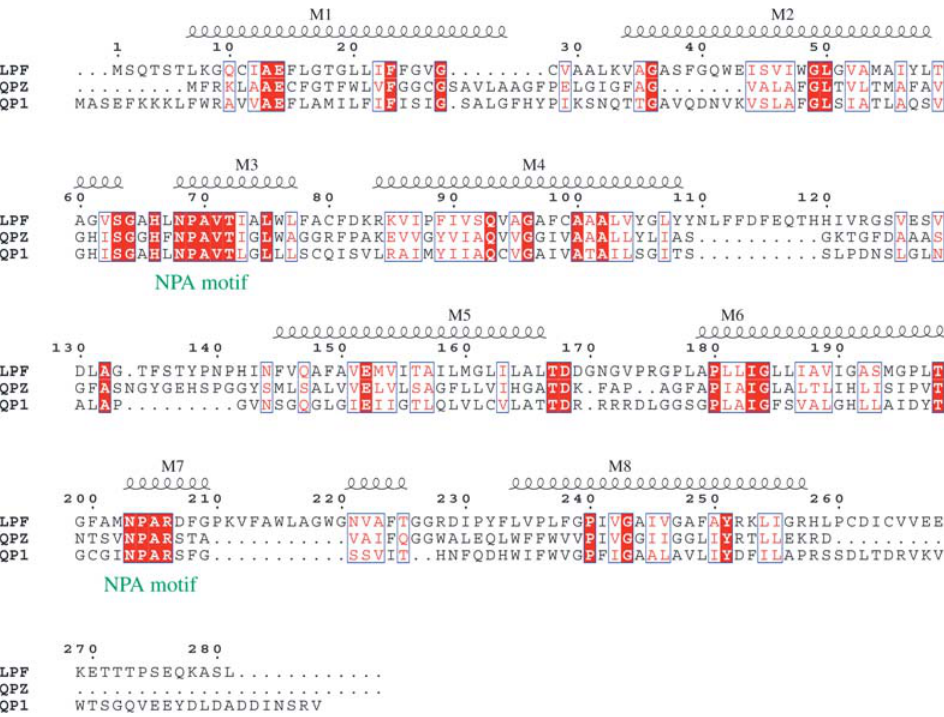
Figure 3. Sequence Alignment of Aquaporins with Known Structure Alignment of GlpF, AqpZ, and AQP1 is numbered according to GlpF. Helices are shown and labeled M1–M8. Residue positions of similar chemical nature are shown in blue boxes; identical residues are shown in red. DOI: 10.1371/journal/pbio.0000072.g003